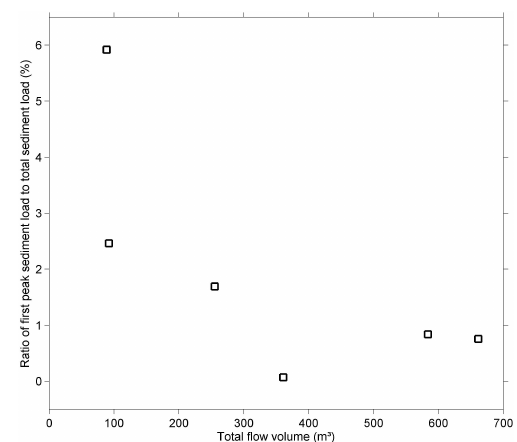
Fig. 11. Ratio of first flush sediment load to total sediment load of natural events as a function of total flow volume in the in the HOAL catchment (64ha) (see Table